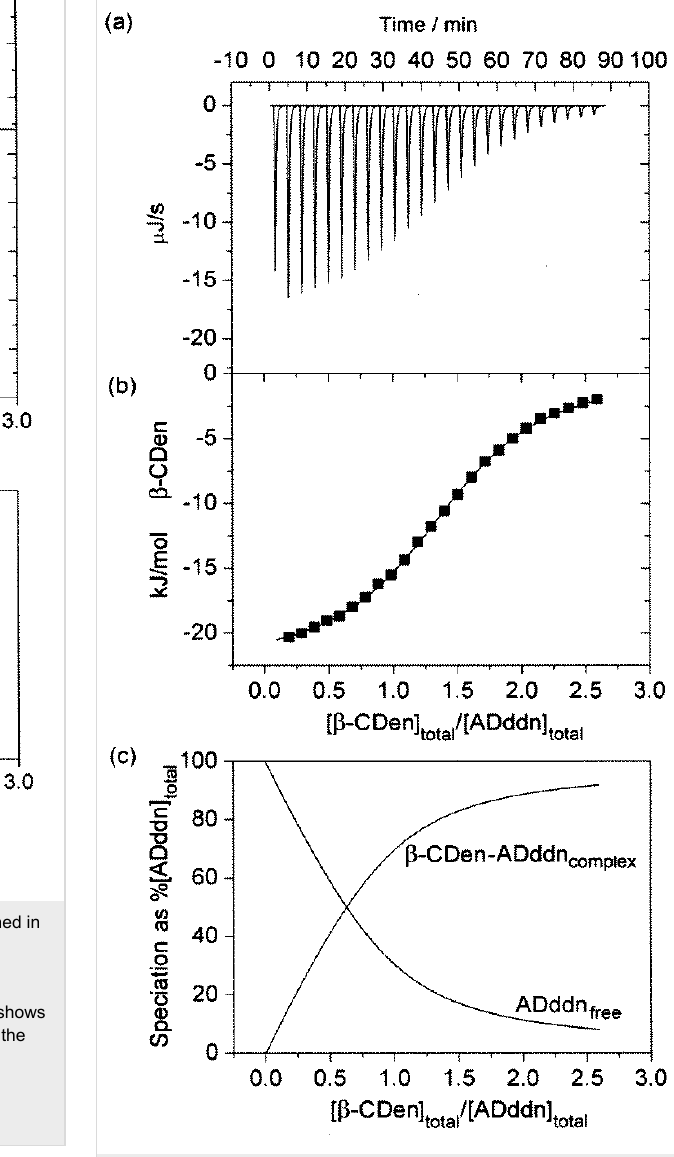
Figure 3: ITC data for the PAA β -CDen/PAAADddn system obtained in aqueous Na 2 HPO 4 /KH 2 PO 4 pH 7.0 buffer at I = 0.10 mol dm − 3 . (a) Titration data: for each system 10 mm 3 aliquots of a 0.62 wt % PAA β -CDen solution ([ β -CDen] = 2.84 × 10 − 3 mol dm − 3 ) into 1.46 cm 3 of 0.064 wt % PAAADddn ([ADddn] = 1.91 × 10 − 4 mol dm − 3 ). (b) The solid curve shows the best fit of an algorithm for host–guest complex- ation between the β -CDen and ADddn substituents to the titration data. (c) Speciation plot showing the variation of [ β -CDen–ADddn] complex and of [ADen] free as a percentage of [ADddn] total =